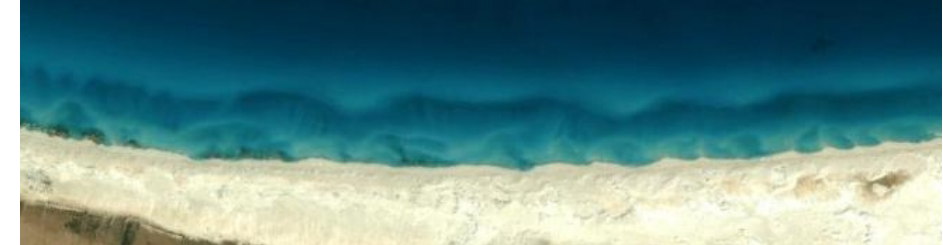
Figure 1. Multiple sandbars along the Libyan coast (Image from Google, DigitalGlobe